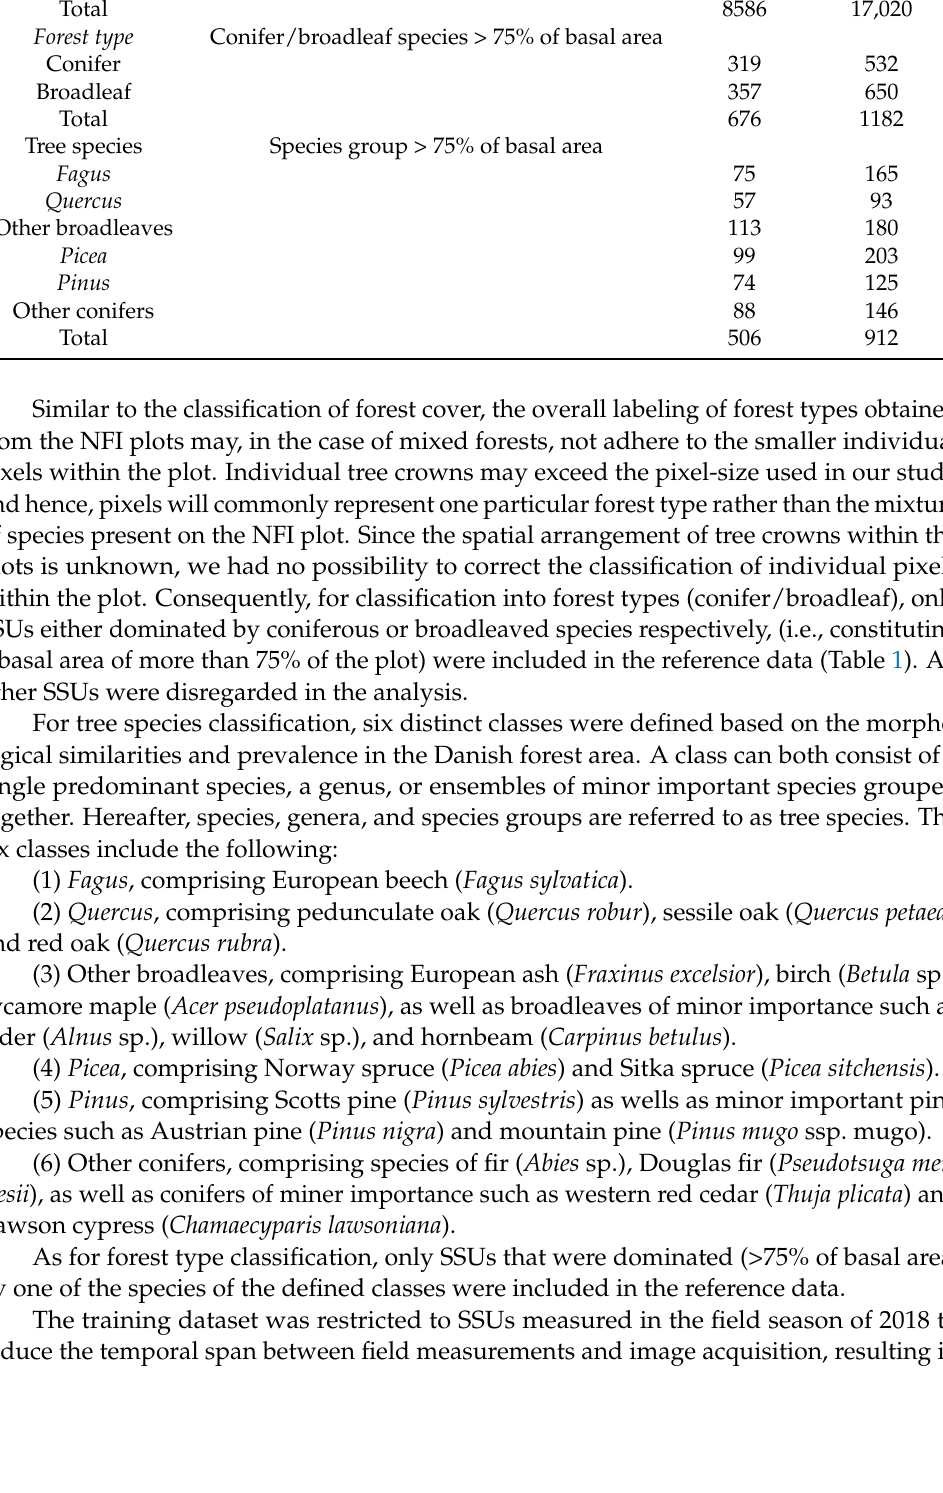
Training Evaluation (2018) (2017,